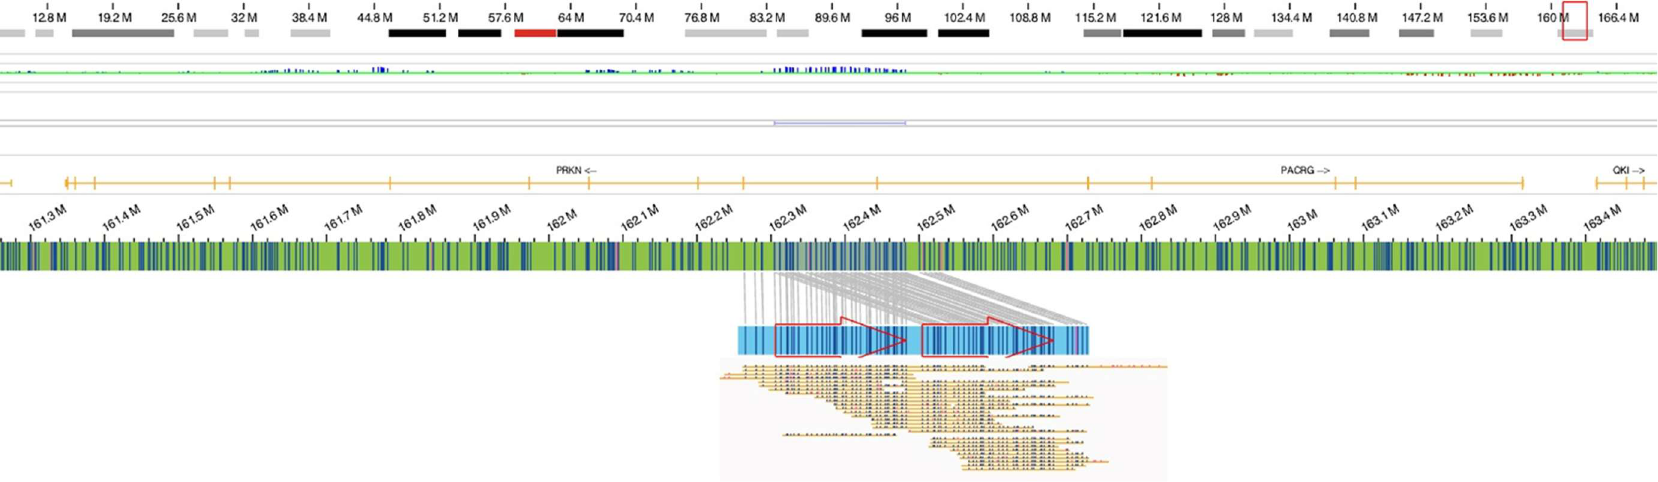
Figure 1. A ~176.7 kb duplication of chr 6 (chr6:162887379–162481424) disrupting the PRKN gene in one patient (case 53). The red arrows indicate a tandem duplication.